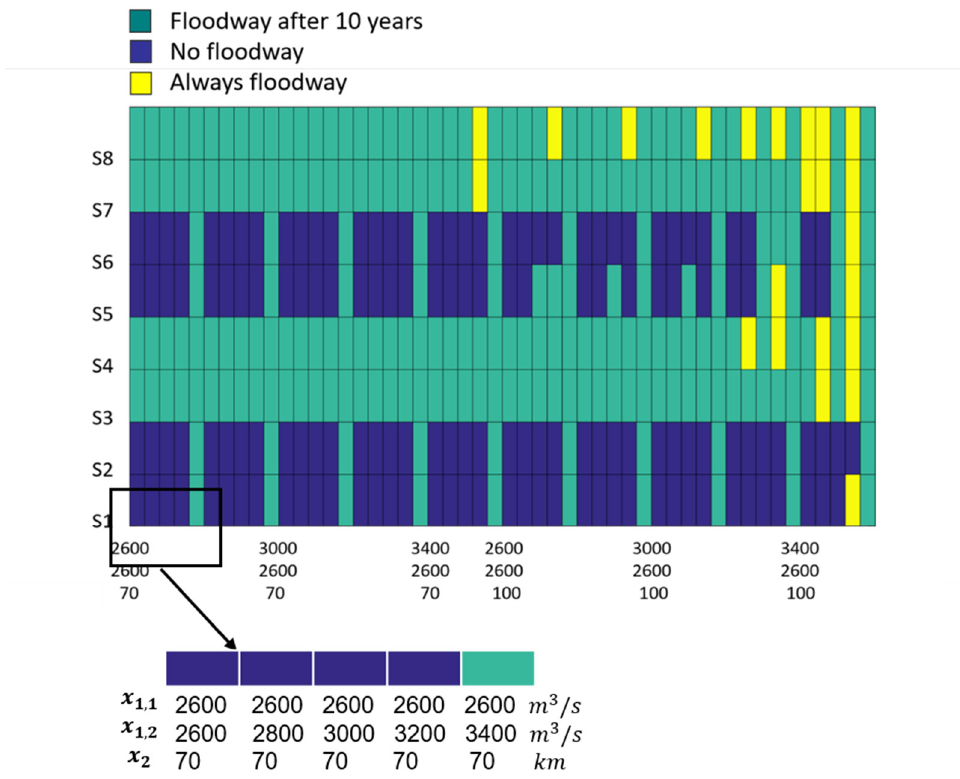
Figure 4. Summary of floodway choices in stages 1 and 2 under each scenario (rows) and each combination of avulsion decisions (columns) (see text for explanation of x axis).